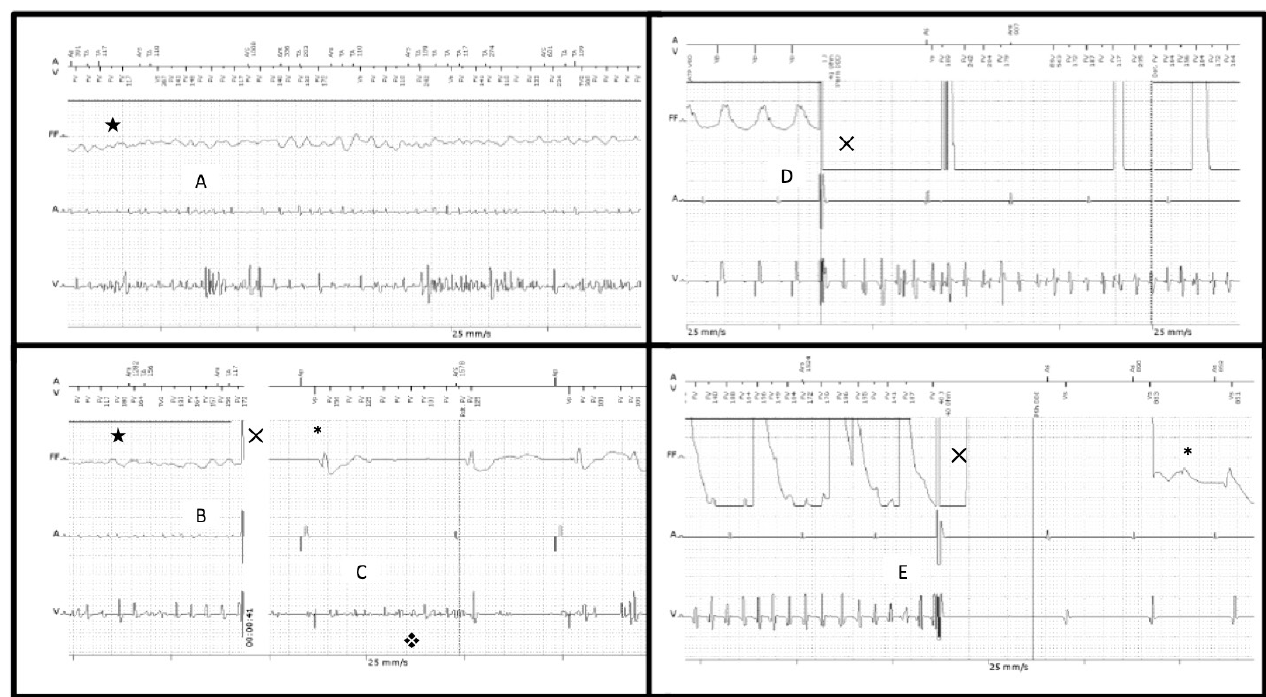
Fig. 2 – (A) Ventricular fibrillation (VF). Fourth appropriate shock finally terminated the arrhythmia (B and C). Notice that the noise remained in the ventricular lead after sinus rhythm restoration (C). A new implantable cardioverter defibrillator-induced VF (t wave shock) (D) would occur later on the defibrillation test (40 Joules) (D) (see Case Report for further details). * sinus rhythm; X shock therapy; ventricular fibrillation; v noise in the ventricular